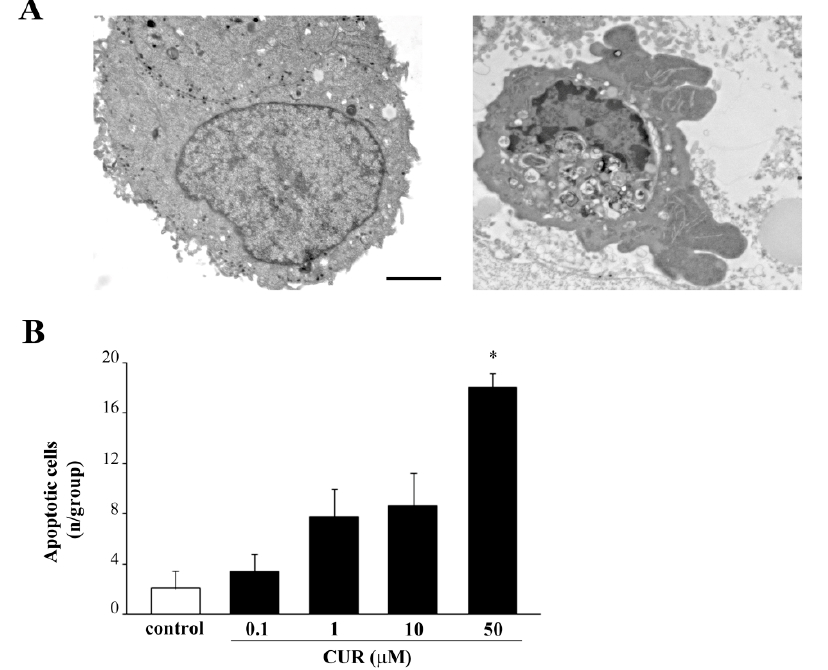
Figure 5. CUR 50 µ M increases the number of apoptotic cells. ( A ) Representative micrographs of PC12 cells of control and following CUR 50 µ M for 72 h. ( B ) The histogram reports the number of apoptotic PC12 cells counted at TEM after CUR administration ranging from 0.1 μ M up to 50 μ M for 72 h. * p ≤ 0.05 compared with control. Scale bar = 1 μ M.